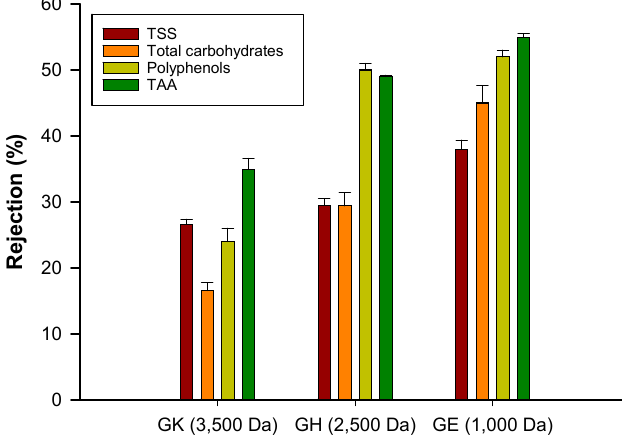
Figure 5. Rejection of GK, GH and GE membranes towards analyzed compounds at a TMP of 16 bar.